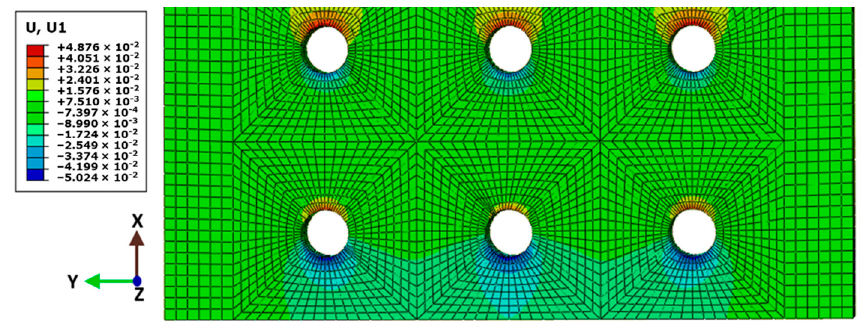
Figure 11. Deformation of X-direction riveted sheet.